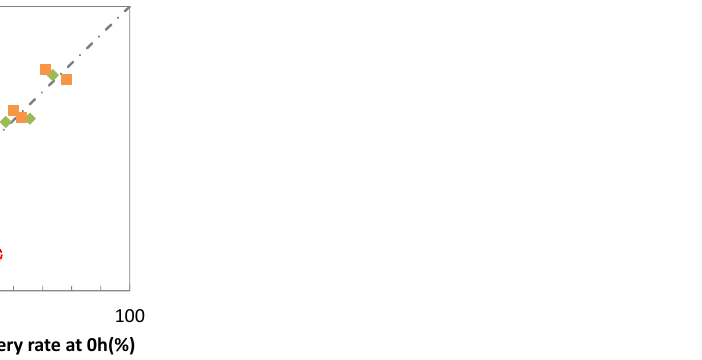
Figure 2. Correlation of nucleic acid recovery rates at 0 h and 6 h. The dotted line indicates nucleic acid recovery rate at 0 h equals to that at 6 h (y = x). Dashed circle indicates the results of copper and its alloys.